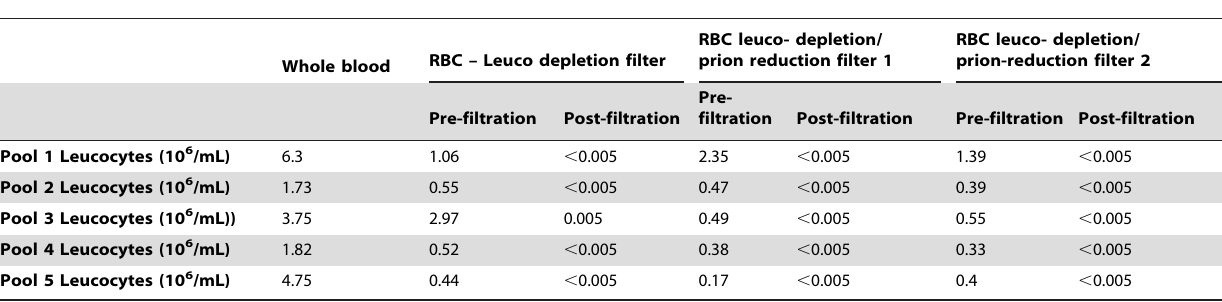
Table 2. Efficacy of the Leuco-depletion and Leuco-depletion/Prion reduction filters on sheep Red Blood Cell concentrates.